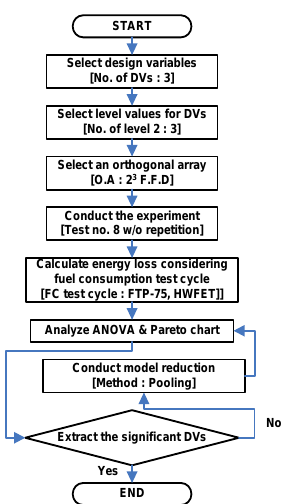
Figure 3. Design procedure of significant factor distinction. ANOVA: analysis of variance.